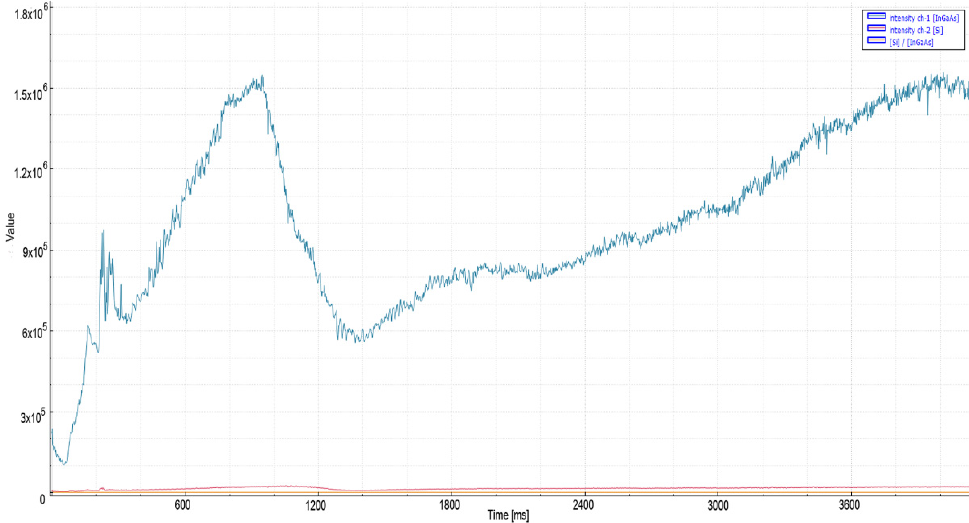
Figure 8. Poor quality oxygen cutting measurement values of 20 mm mild steel material.